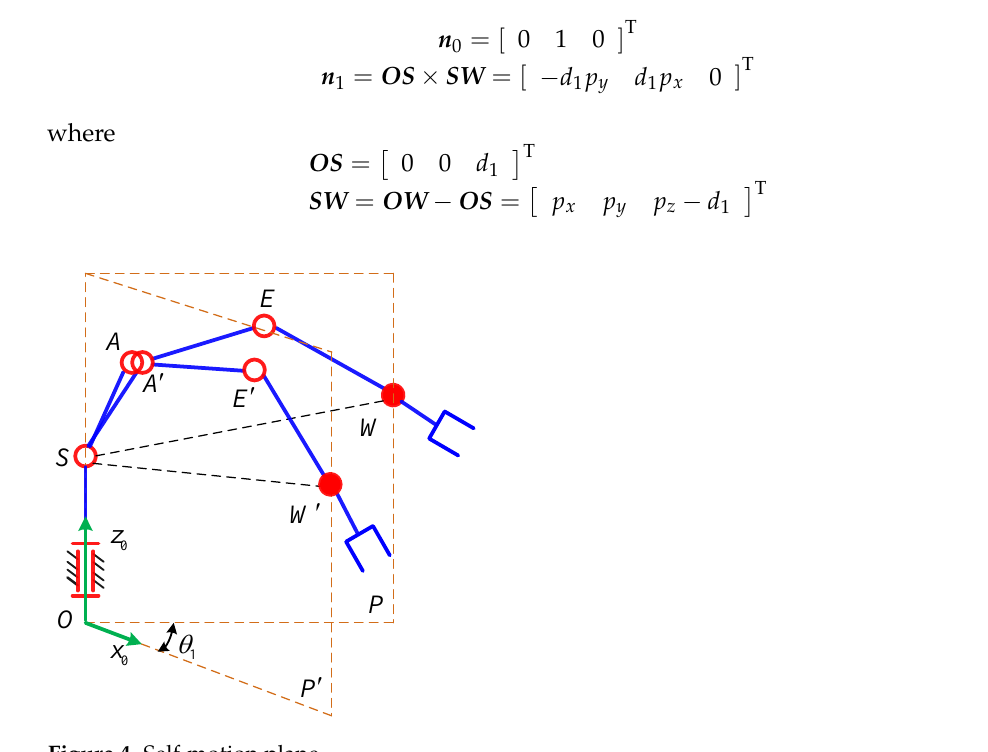
Figure 4. Self-motion plane.